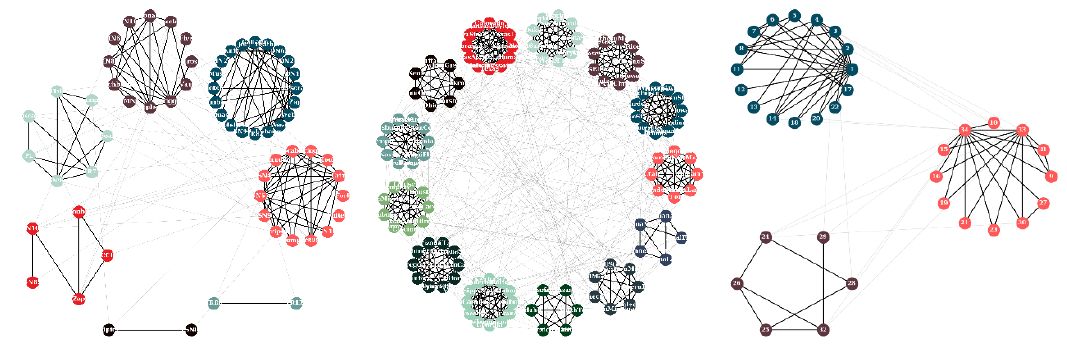
Figure 4. The results of community detection for three networks. Left: Dolphins. Middle: Football. Right: Karate.